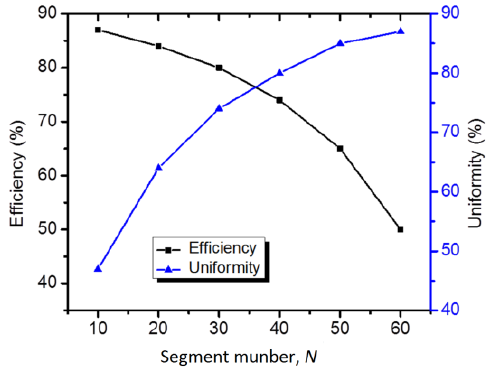
Figure 10. Efficiency and uniformity depend on the number of segments N .